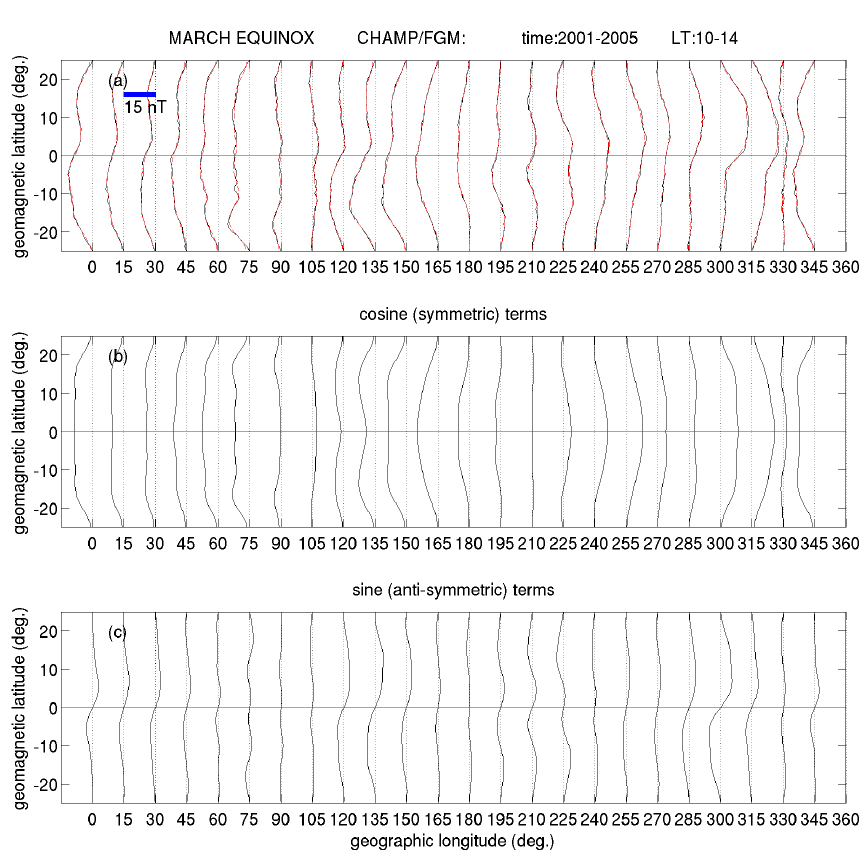
Fig. 1. Examples of average magnetic field deflection at low latitude; (a) linearly detrended latitudinal profile of the zonal residual field. (b) Symmetric component with respect to the dip equator. IHFAC can be estimated from this component. (c) Anti-symmetric component with respect to the dip equator. The standard error of the mean is below 0.6nT for each curve in a longitude bin due to the large number of observations (1600–4900 per